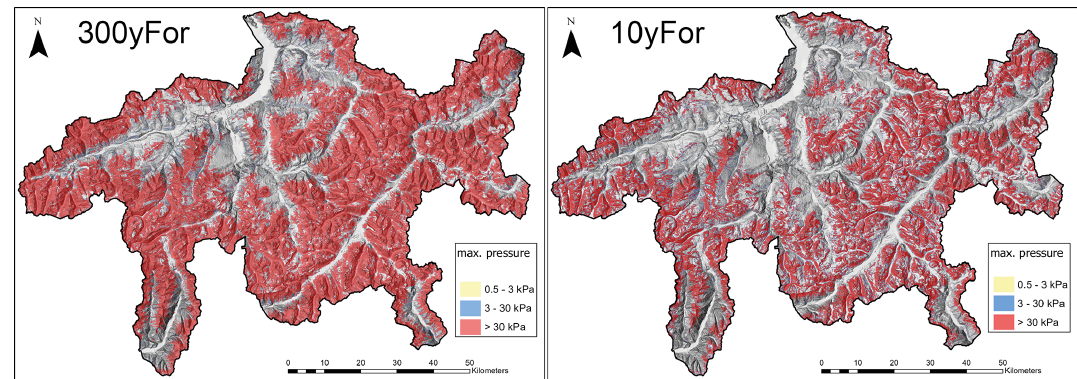
Figure 7. Simulation result for the entire canton of Grisons for the rarest (300 years, left) and the most frequent (10 years, right) scenario, taking the protective effects of the forest into account (hillshade source: Swiss Federal Office of